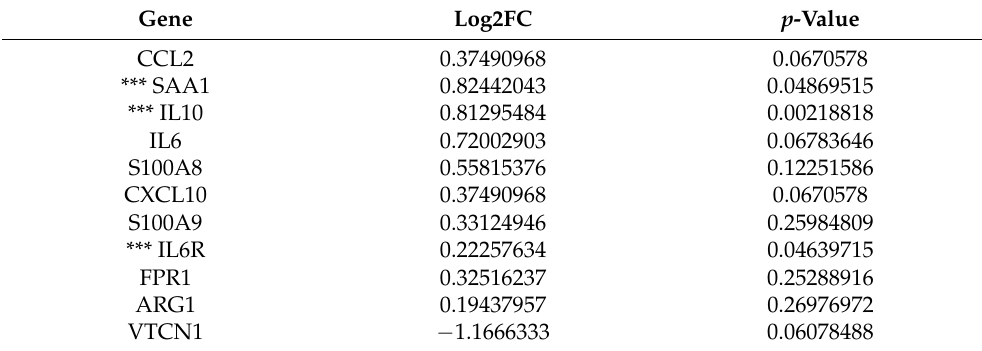
Table 1. Immunomodulators highly expressed in normal breast tissue samples from obese patients.